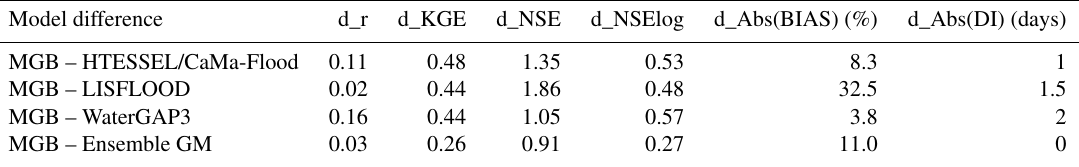
Table 3. Median values of discharge metrics for South America, computed as the performance difference between continental and global models. Lower values show better performance for a given global model when benchmarked against the MGB continental hydrologic– hydrodynamic model. Gauge stations with naturalized flows were removed from the analysis to provide a fair